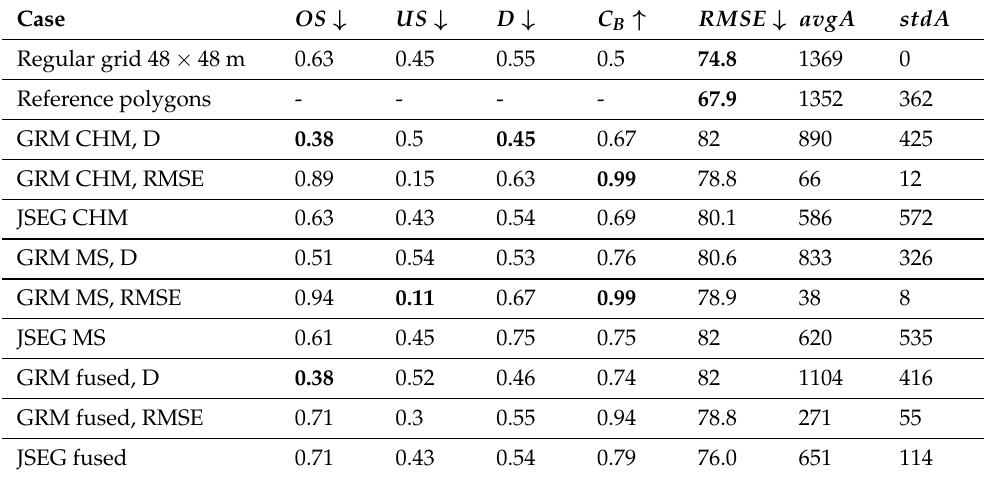
Table 4. Supervised metrics. Arrows better. The best value for each metric is emphasised with bold